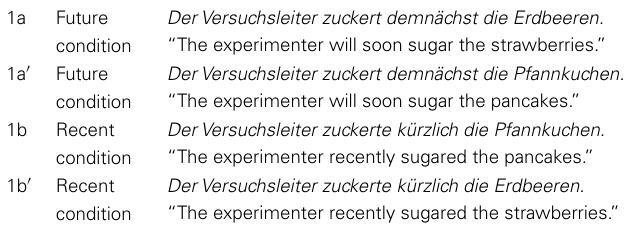
Table 1 | Example item set for Experiments 1 and